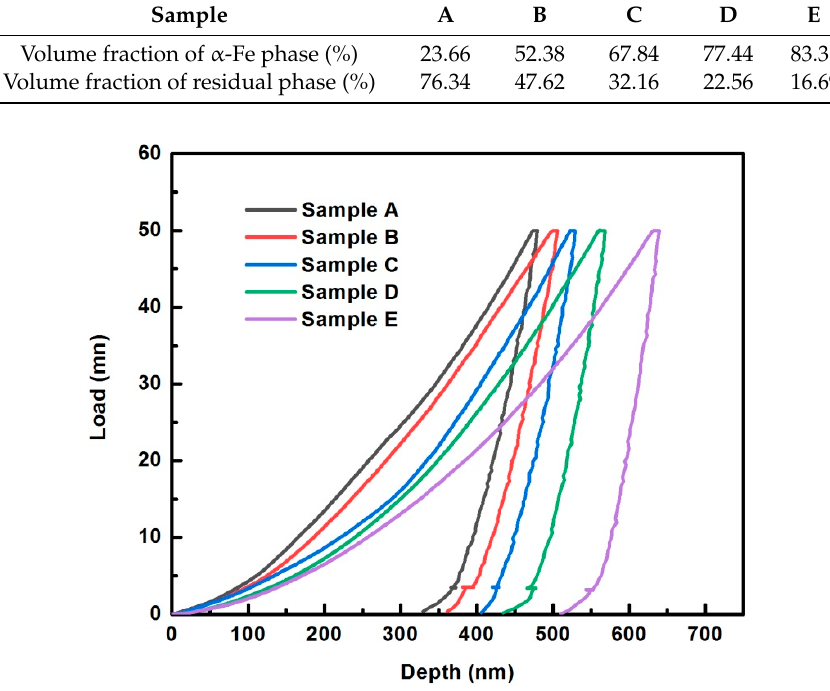
Figure 4. Representative load ‐ depth nanoindentation curves for different printed samples.